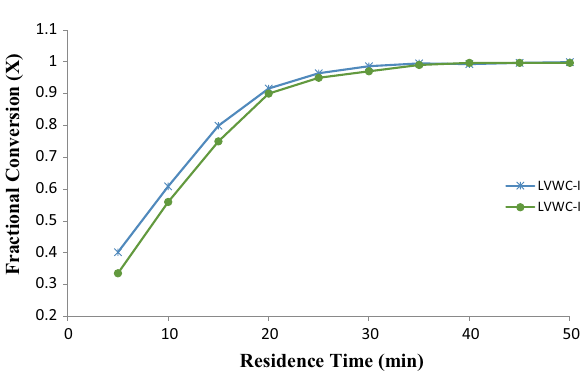
Fig. 2 Plot between fractional conversion ( X ) and residence time